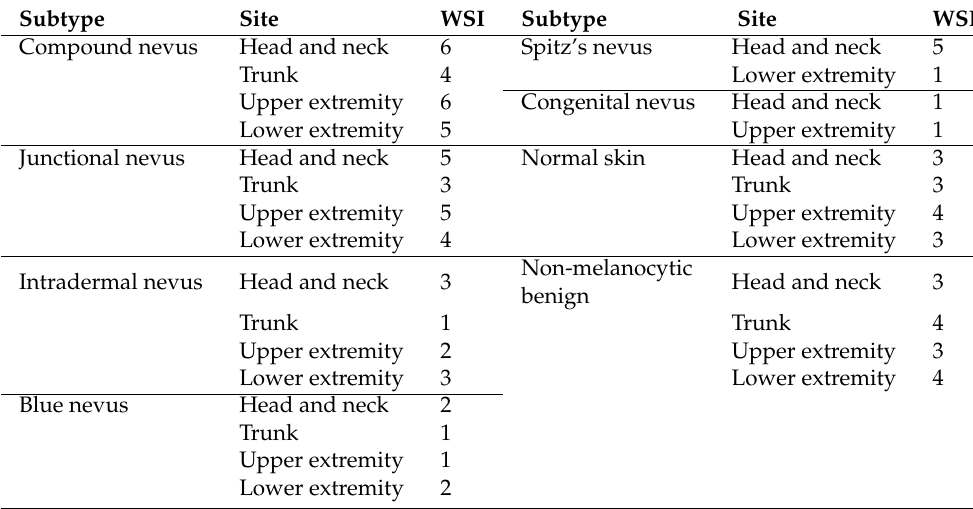
Table 2. The composition of the 88 non-melanoma subtype cases.